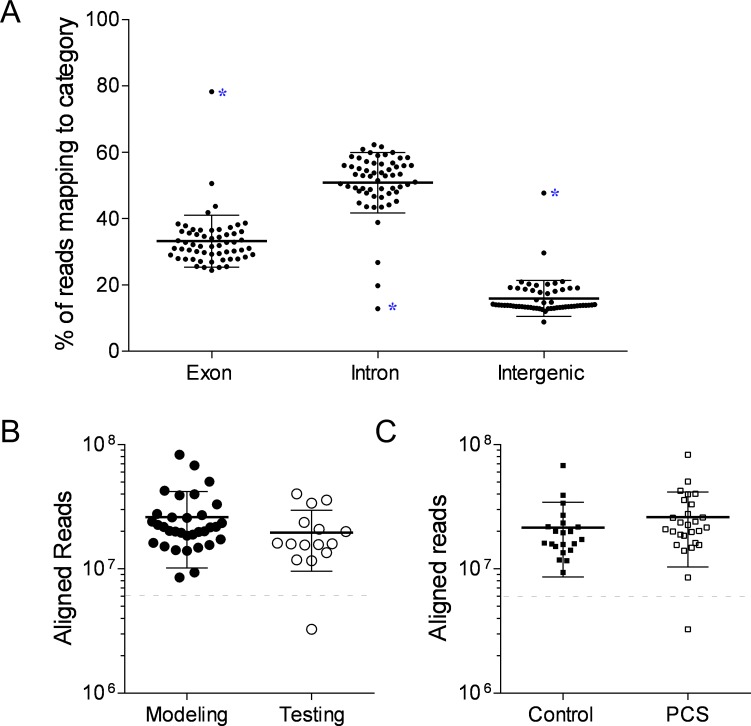
Male gene read alignment to the hg19 reference genome and mapping to the RefSeq Annotation Guide.A. Average mapping proportions were 33.2% exonic, 50.8% intronic, and 15.9% intergenic. Blue asterisk indicates excluded sample. B & C Average alignment was 24 million reads/ sample. Data are shown stratified by clinical condition (B: PCS vs Control) and data group (C: Modeling vs Testing). The dashed line denotes the 5 million read cut off.